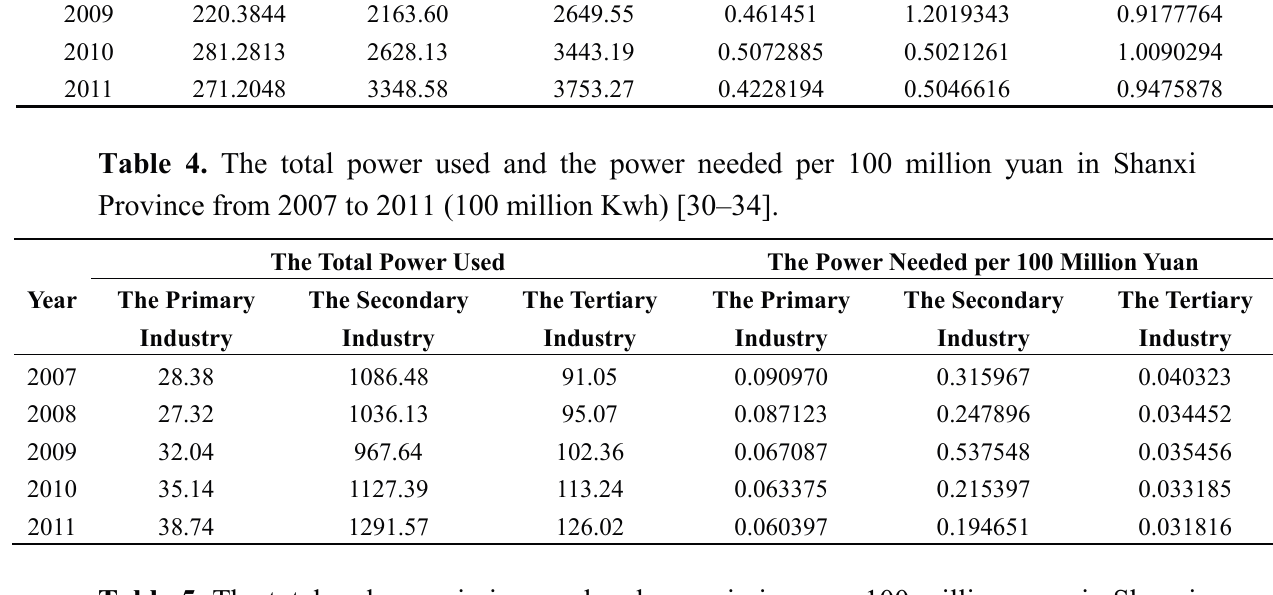
Table 5. The total carbon emissions and carbon emissions per 100 million yuan in Shanxi Province from 2007 to 2011 (100 million tons). Sources: Calculating according to the data from [30–34].